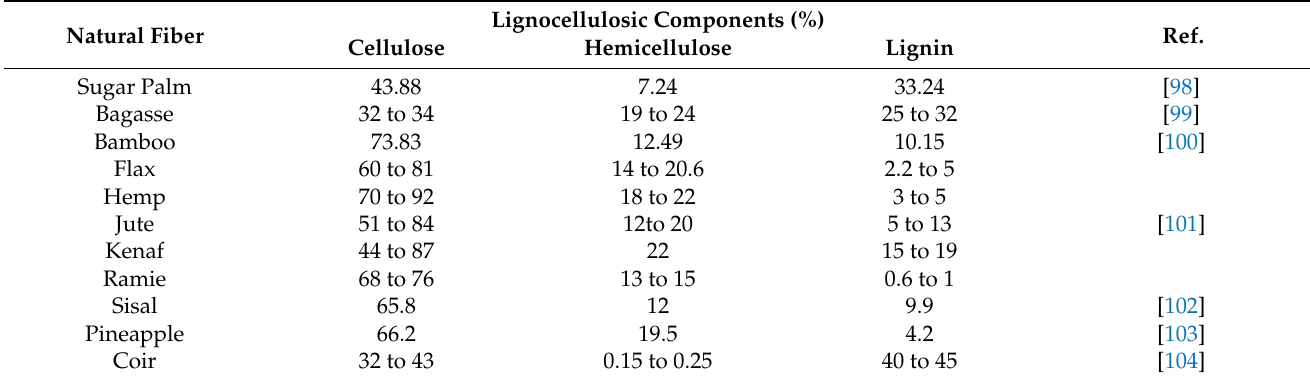
Table 2. Chemical composition of lignocellulosic